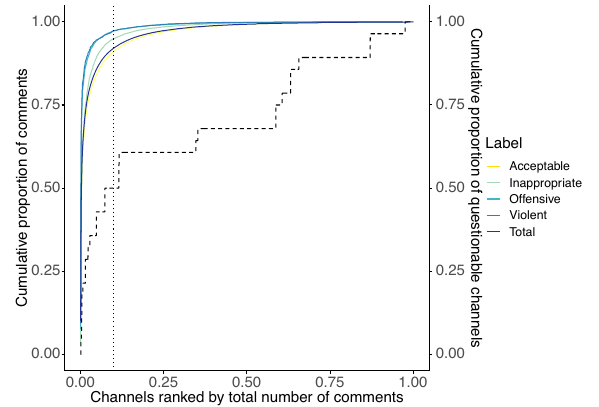
Figure 2. Ranking of YouTube channels by number of comments and proportions of comment types per channel.